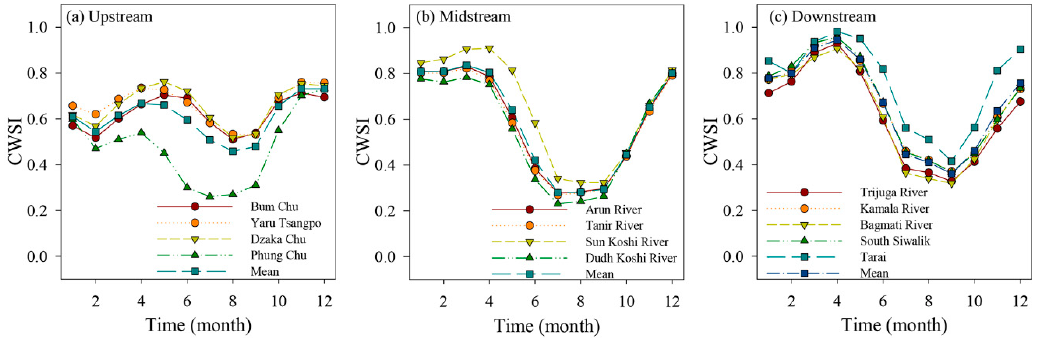
Figure 4. Annual distribution of Drought degree in Koshi River Basin (KRB).